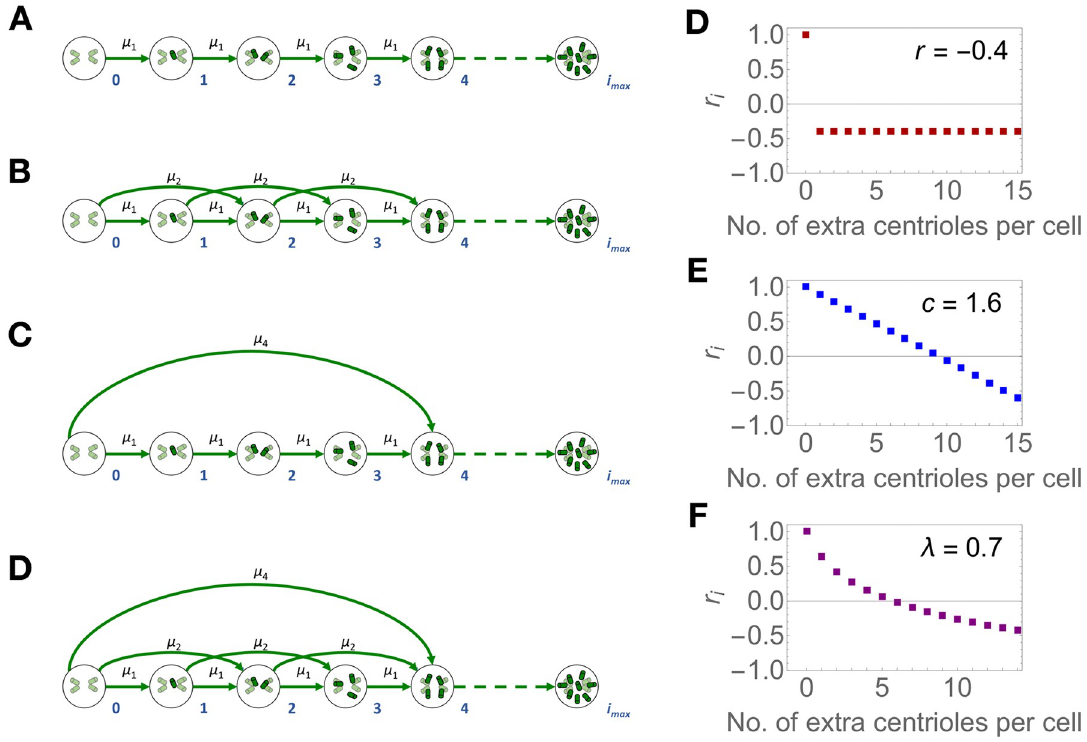
Fig 2. Centriole overproduction and fitness functions in the candidate models. A—Single-step centriole overproduction at rate μ 1 . B —single- and double-step centriole overproduction events at rates μ 1 and μ 2 , C—single- and quadruple-step centriole overproduction events at rates μ 1 and μ 4 , D—and all three centriole overproduction events. Circles represent the subpopulation of cells containing i extra centrioles (green cylinders, i indicated by the numbers in blue). Green arrows represent transitions between subpopulations, which correspond to centriole overproduction, occurring at rates μ 1 , μ 2 or μ 4 . Overproduction events can occur for all i up to i max . (E-G) The value of r for cells with i centrioles under the (E) flat, (F) linear, and (G) power-law fitness functions, evaluated at the indicated i parameter values.